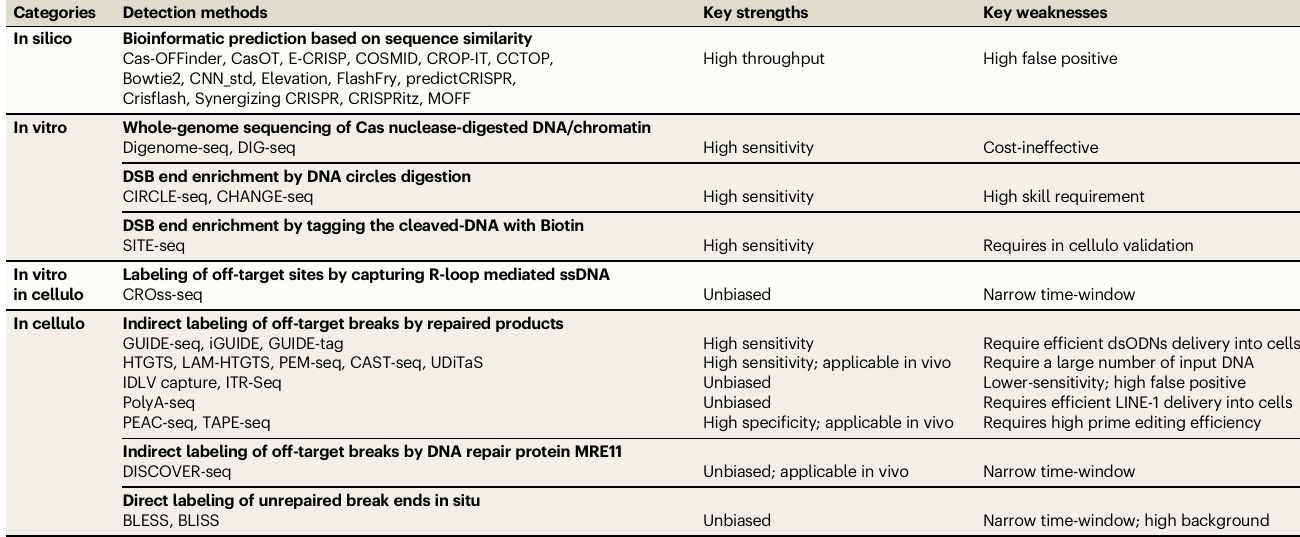
Table 1 | A summary of methods for identifying genome-wide CRISPR-Cas off-target